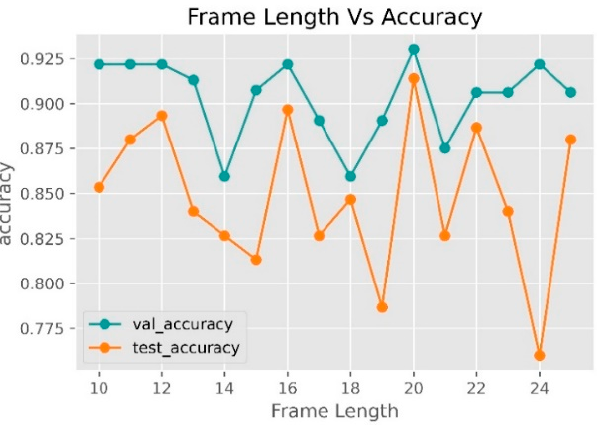
Figure 4. Frame length vs. accuracy curve.